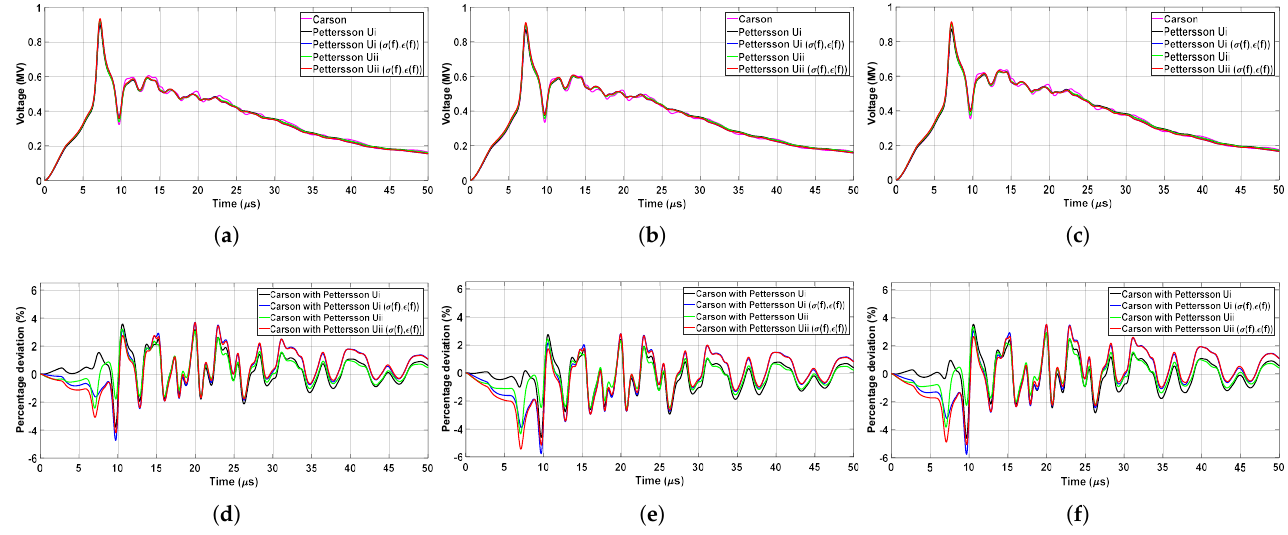
Figure 14. Overvoltage waveform in phases A ( a ), B ( b ) and C ( c ) and percentage differences, based on Carson’s formulation, for phases A ( d ), B ( e ) and C ( f ), considering ground resistivity equal to 10,000 Ω .m and a lightning stroke current waveform with α =